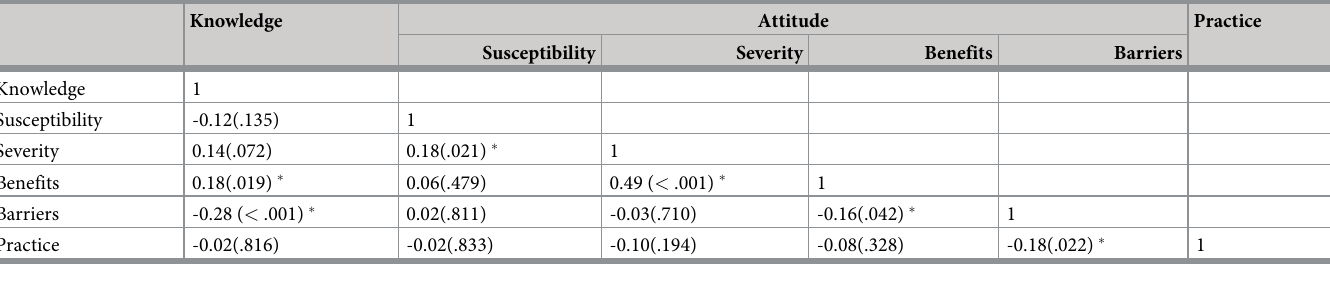
Table 4. Correlations between nutritional knowledge, attitudes, and